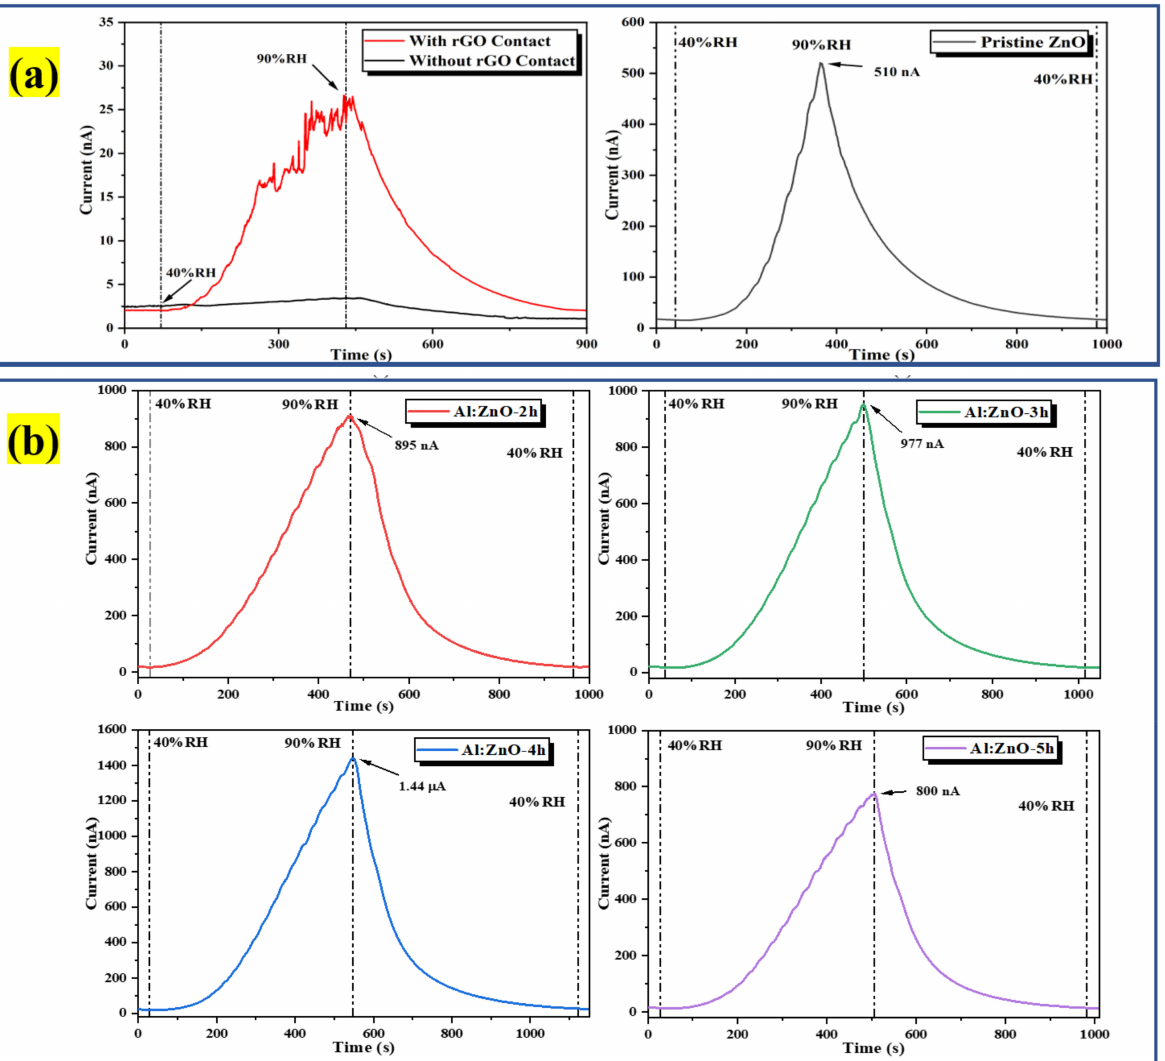
Figure 12. Humidity response of the ( a ) bare substrate with and without rGO contact and pristine ZnO; and ( b ) Al:ZnO-based flexible humidity sensors with varying doping immersion time at humidity levels from 40% to 90 %RH with 5 V